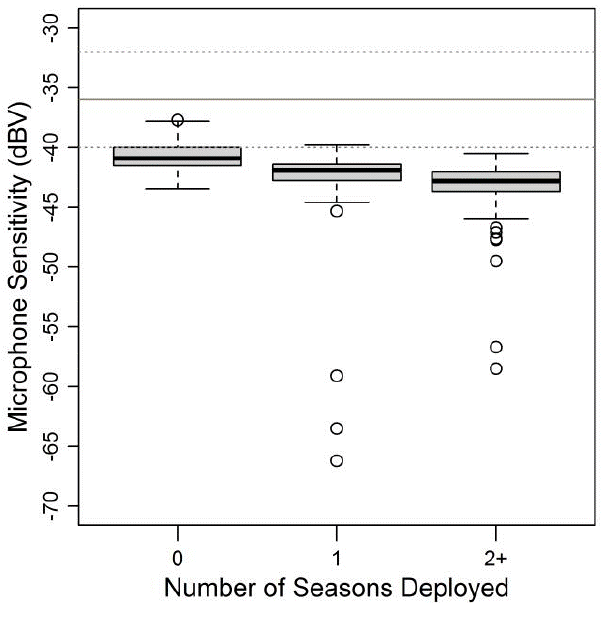
Fig. 3 . Frequency distribution of sensitivity readings obtained from 143 new SMX-II microphones for SM2 recorders (Wildlife Acoustics, Maynard, Massachusetts, USA). Microphone specifications are